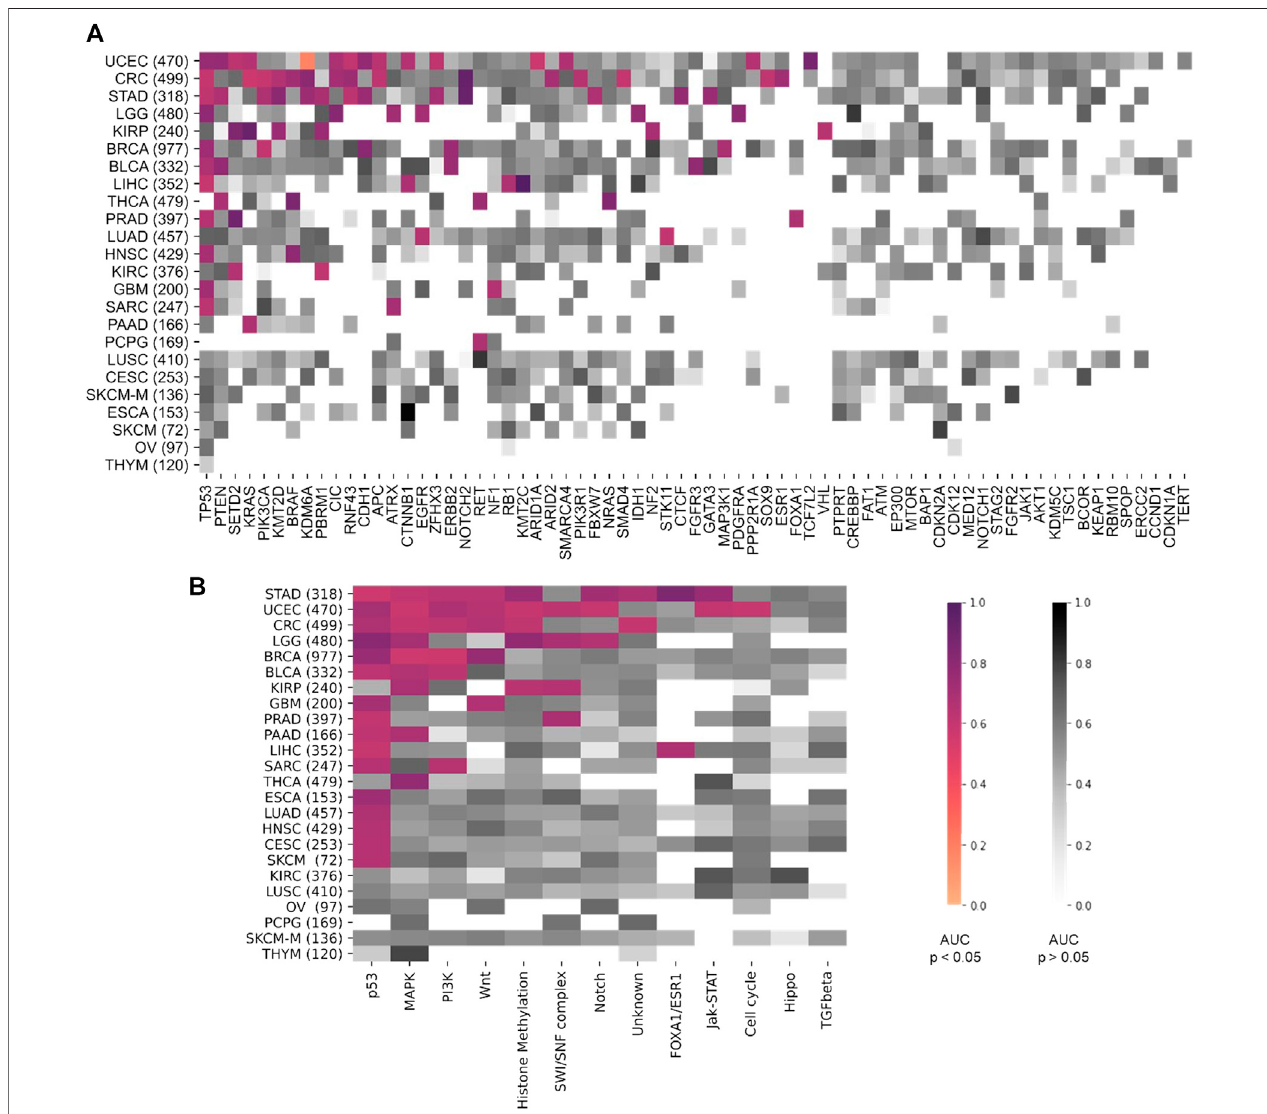
FIGURE 2 | Heatmap comparing the area under the receiver operating curve (AUROC) between the different tumor types. On the y-axis all tumor types are listed and sorted by tumor with most signi fi cant results from top to bottom. Number of patients indicated in brackets behind. Pathways are ordered on the x-axis from most (left) to least (right) signi fi cant results. AUROC values for (A) the twelve pathway analysis and (B) for the 69 gene analysis. Coloured values stand for signi fi cant detected ( p > 0.05) pathways and grey for not signi fi cantly ( p > 0.05). TCGA tumor type abbreviations are used (https://gdc.cancer.gov/resources-tcga-users/tcga-code-